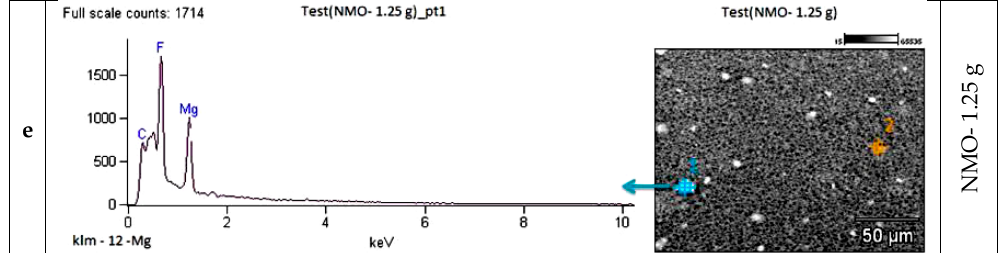
Figure 4. SEM/EDX spectra Mapping the Presence of NMO in ( a – e ) membrane. Figure 4. SEM / EDX spectra Mapping the Presence of NMO in ( a – e ) membrane.